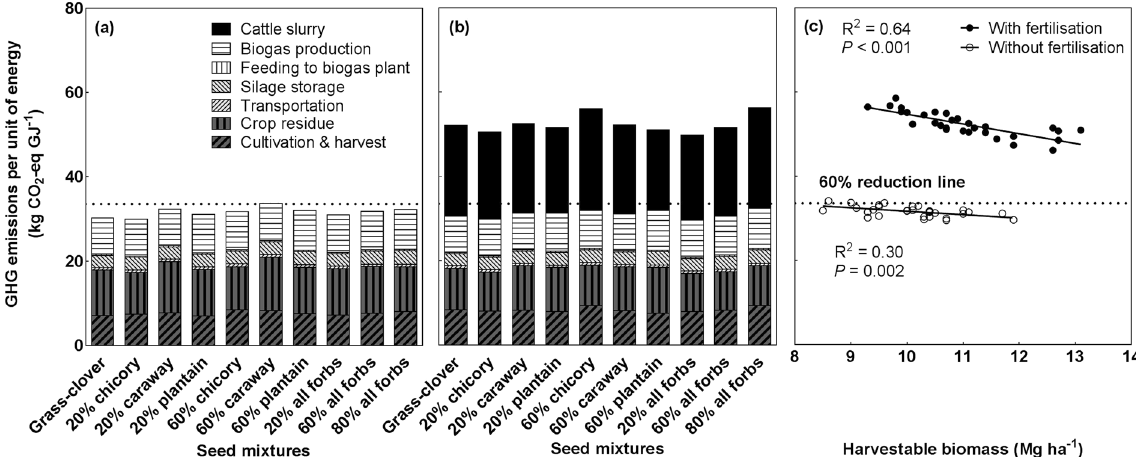
Figure 6. Greenhouse gas (GHG) emissions per energy unit in the 10 seed mixtures without ( a ) and with fertilisation ( b ), and plotted against harvestable biomass yields ( c ). The dashed horizontal line denotes 60% reduction in GHG emissions compared to fossil fuel. Different hatched bars denote various sources of GHG emissions ( a , b ). Significant linear regressions and coefficients of determination were shown ( c ). For detailed calculations of GHG emissions, please see Supplementary Text and Table